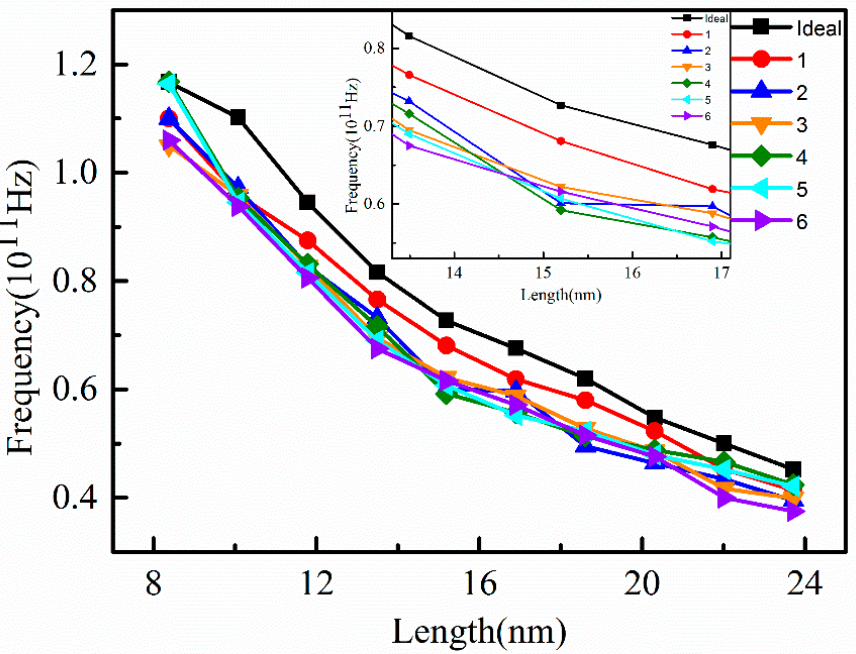
Figure 4. Vibration frequency with length of graphene nanoribbons with different vacancy concentrations.